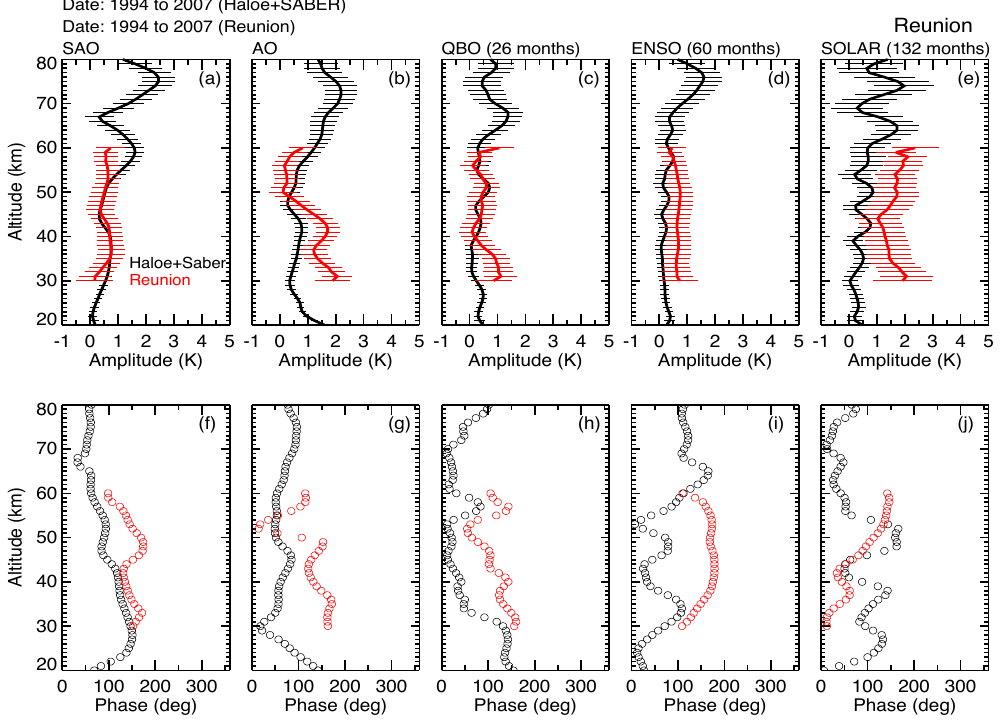
Figure 7: Same as figure 6 but over Reunion location. Fig. 7. Same as Fig. 6 but over Reunion